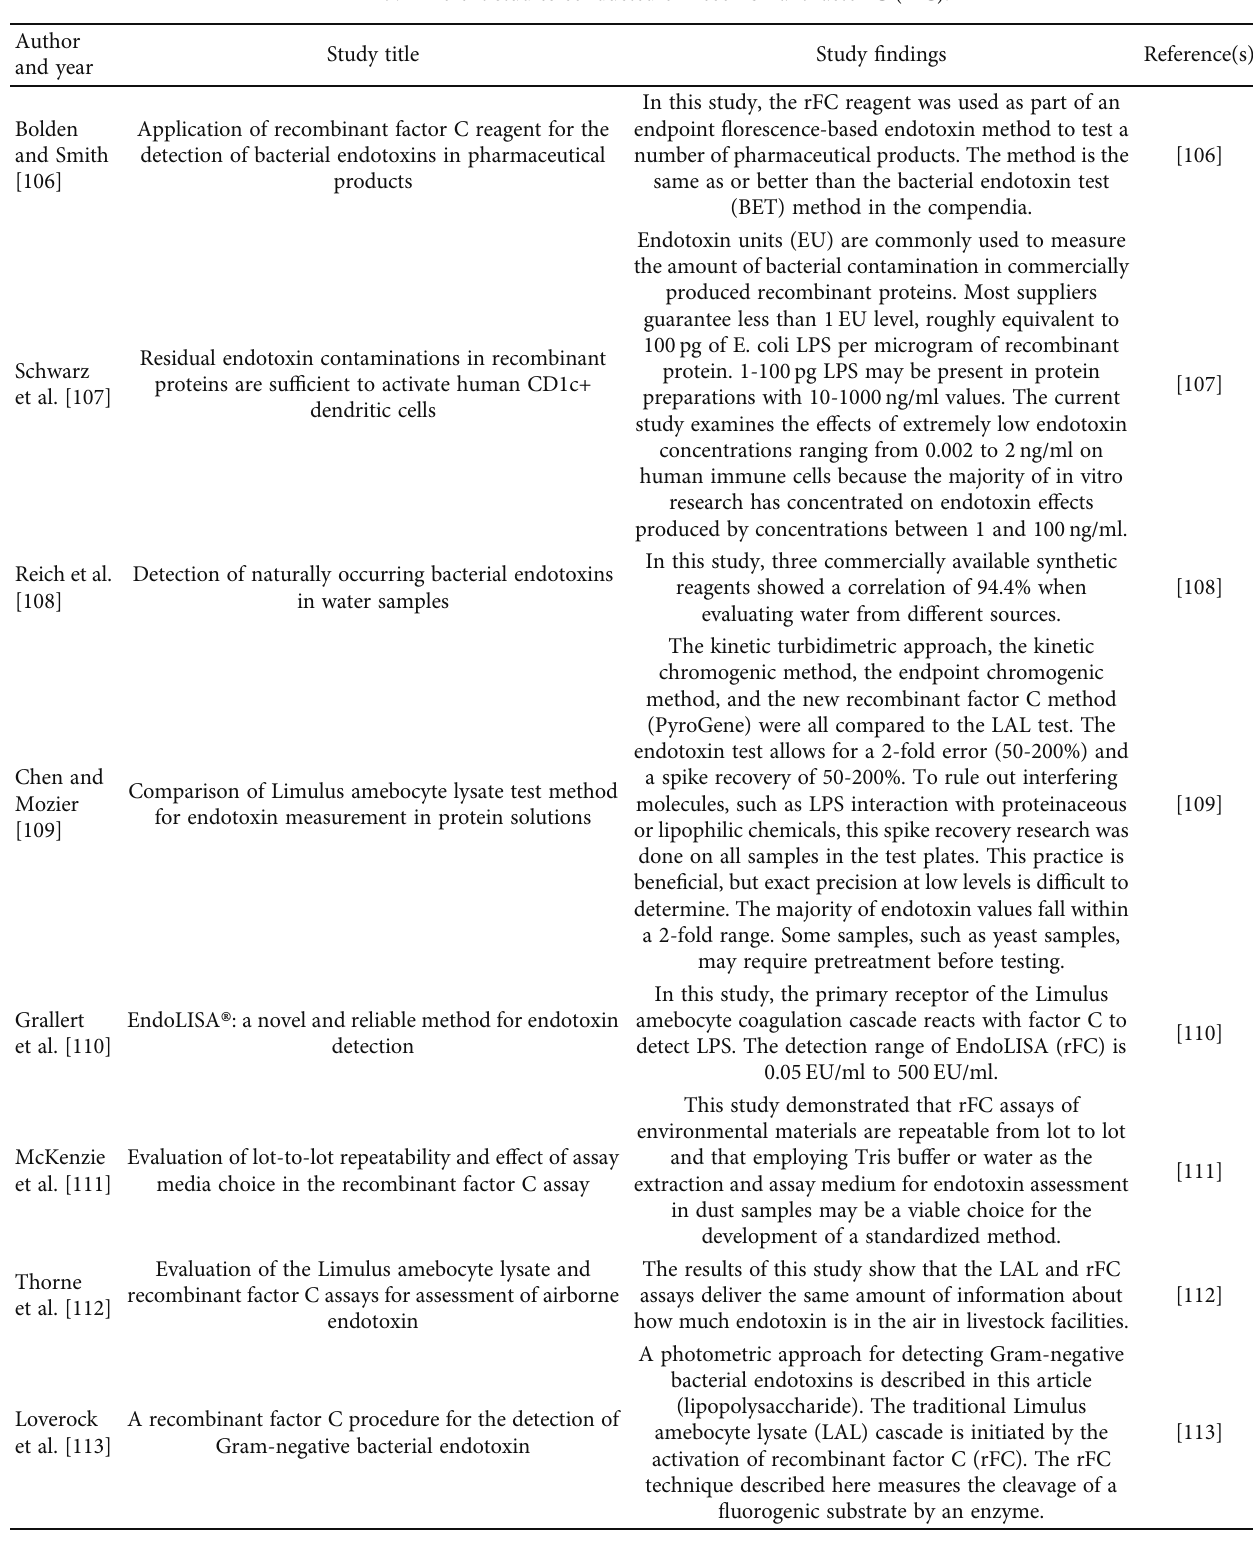
Table 7: Di ff erent studies conducted on recombinant factor C